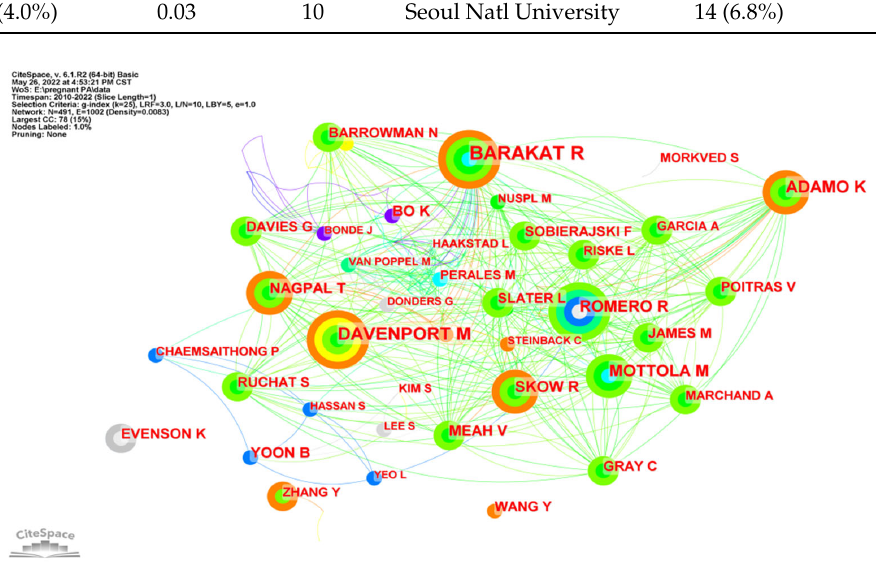
Figure 6. Co ‐ occurrence map of authors researching physical activity during pregnancy. Figure 6. Co-occurrence map of authors researching physical activity during